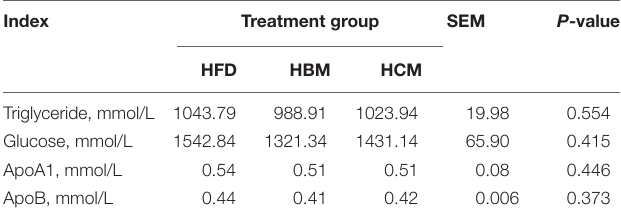
TABLE 6 | Effects of buffalo and cow milk on the expression level of genes involved in the hepatic lipid metabolism in high-fat diet fed mice ( n = 6). Gene Treatment